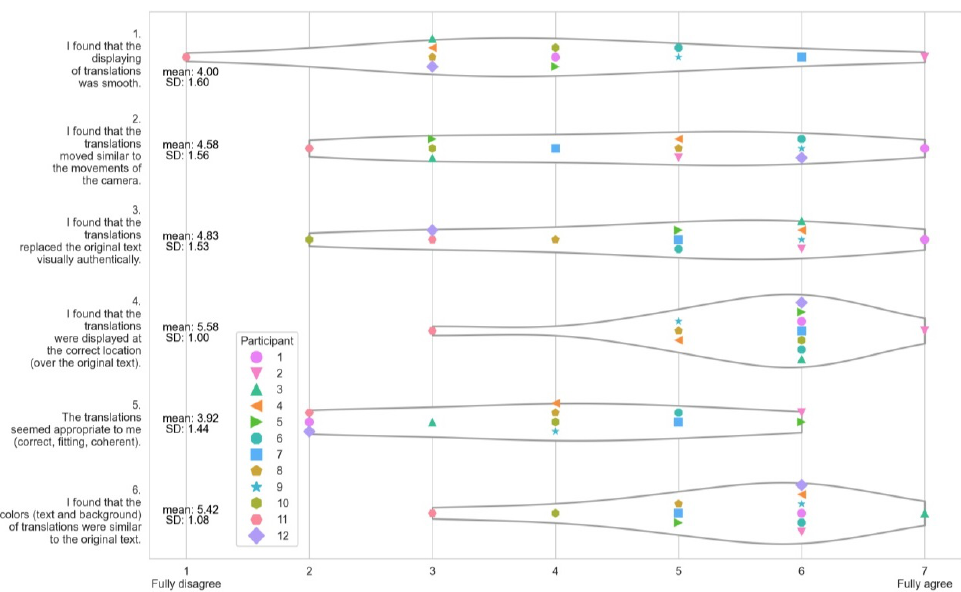
Figure 6. Questionnaire results per participant for the AR translator application